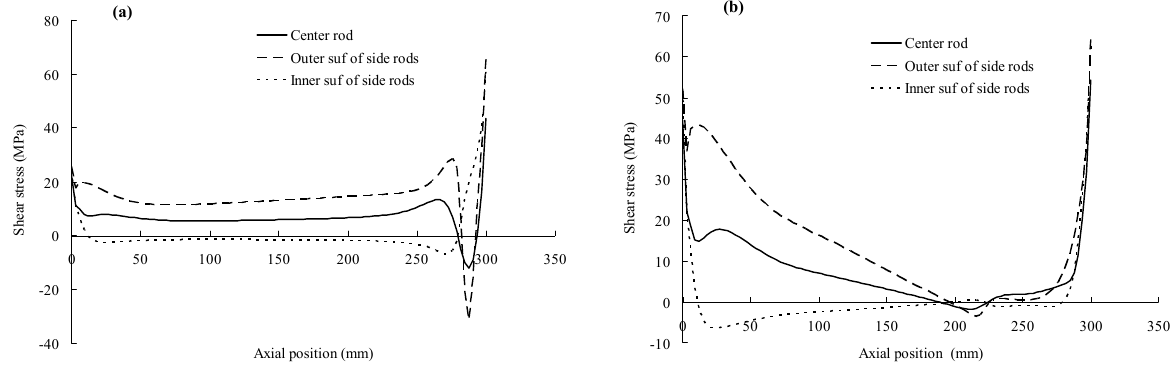
Figure 12. ( a ) The shear stress distribution of the 3% angle anchor; ( b ) the shear stress distribution of a straight-parabolic angle